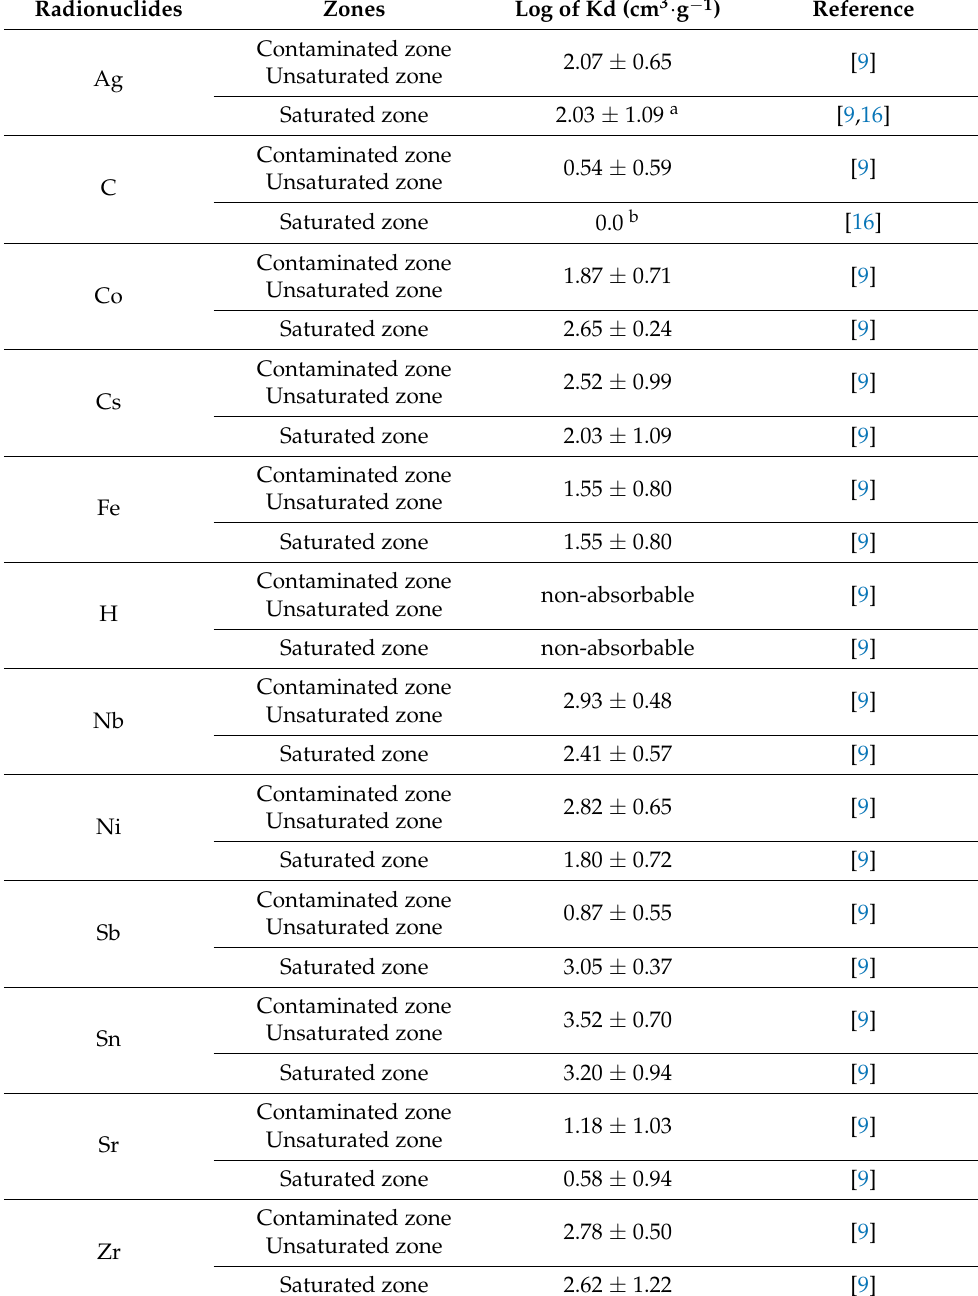
Table 2. Distribution coefficients of various